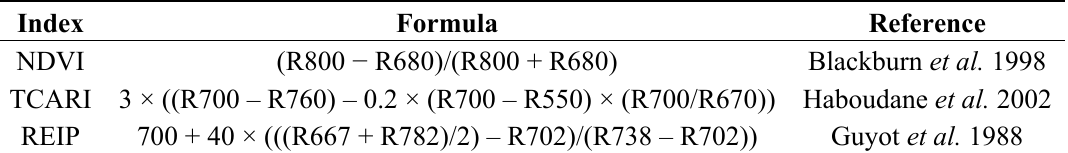
Table 2. Vegetation indices used in this study and their underlying